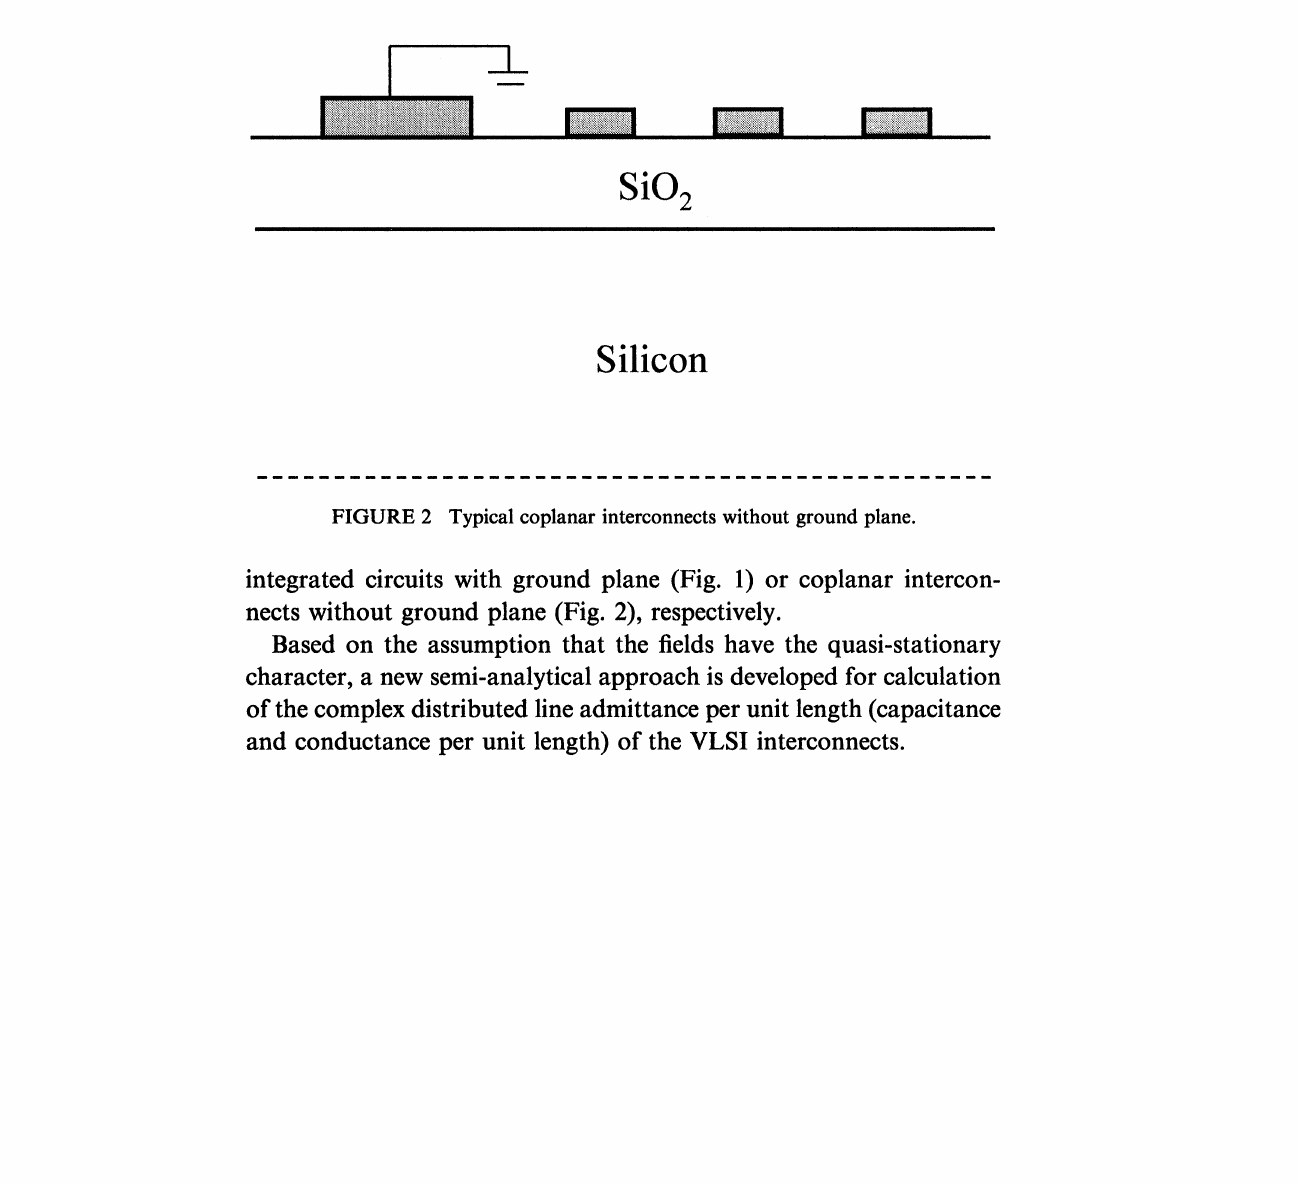
FIGURE Typical on-chip interconnects used in mixed-signal intergrated circuits with ground plane.